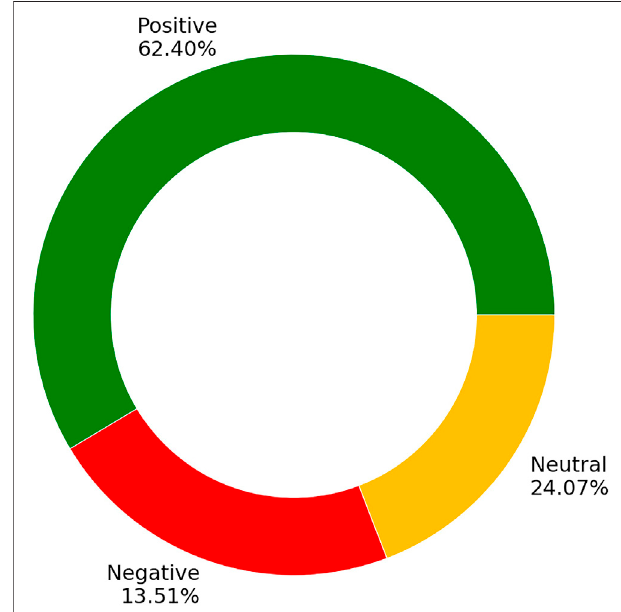
FIGURE 3 | Overall public sentiment on policing performance.